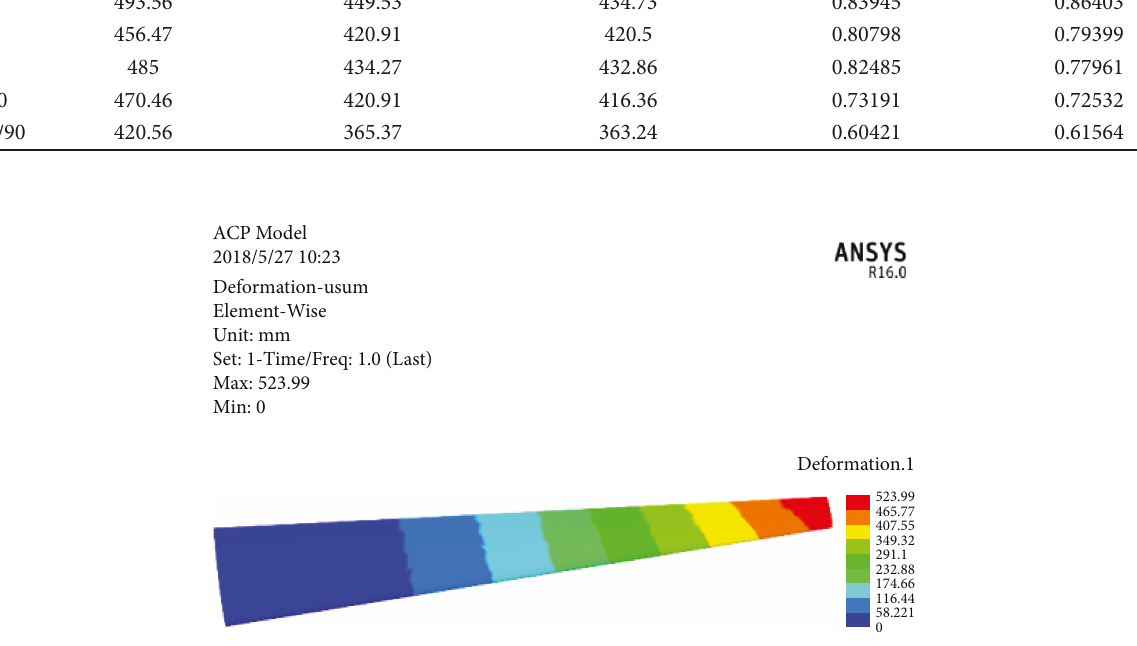
Figure 41: Deformation cloud diagram with the layer ratio being